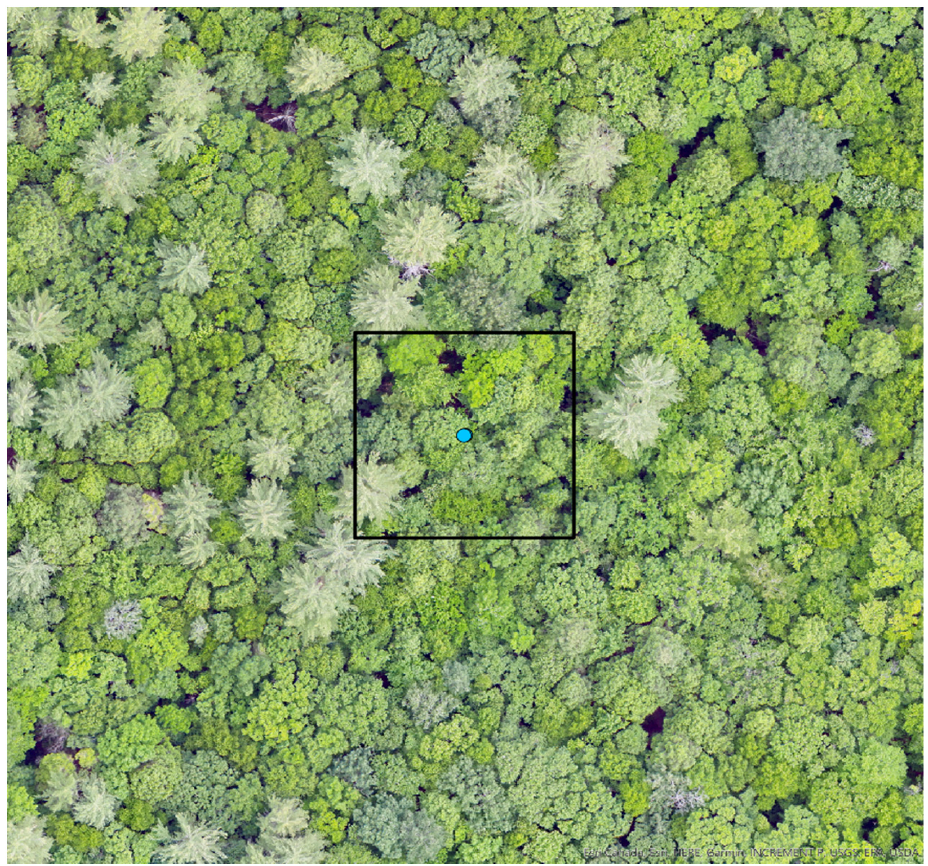
Figure 1. Representation of the forest diversity found within each of the woodland properties. Displayed are the plot center (blue dot) for a singular Continuous Forest Inventory (CFI) plot, as well as a 30 × 30 m buffer placed around this plot. This UAS image shows a complex New England Forest with a variety of species including eastern white pine ( Pinus strobus, Linnaeus ), eastern hemlock ( Tsuga canadensis, (L.) Carrière ), northern red oak ( Quercus rubra, F. Michaux ), red maple ( Acer rubrum, L. ), and American beech ( Fagus grandifolia, (Ehrh.) ). Each study site consisted of similarly high stem densities, with diverse and overlapping tree crowns.